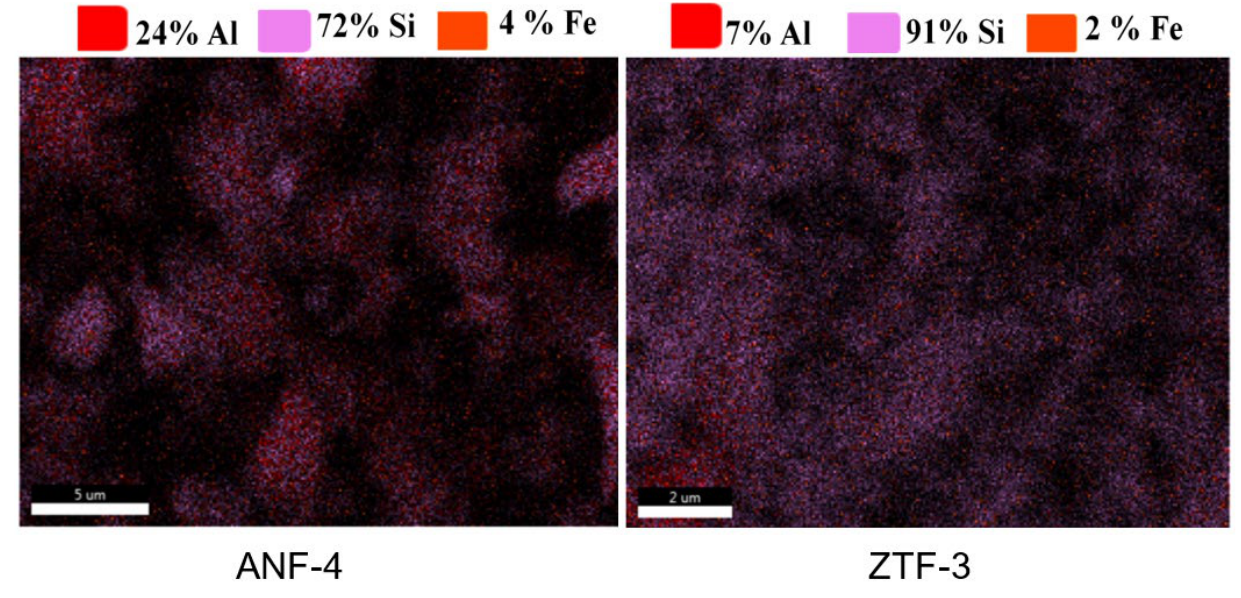
Figure 8. EDS mapping of aluminosilicates and ZSM-5 impregnated by Fe 3+ .